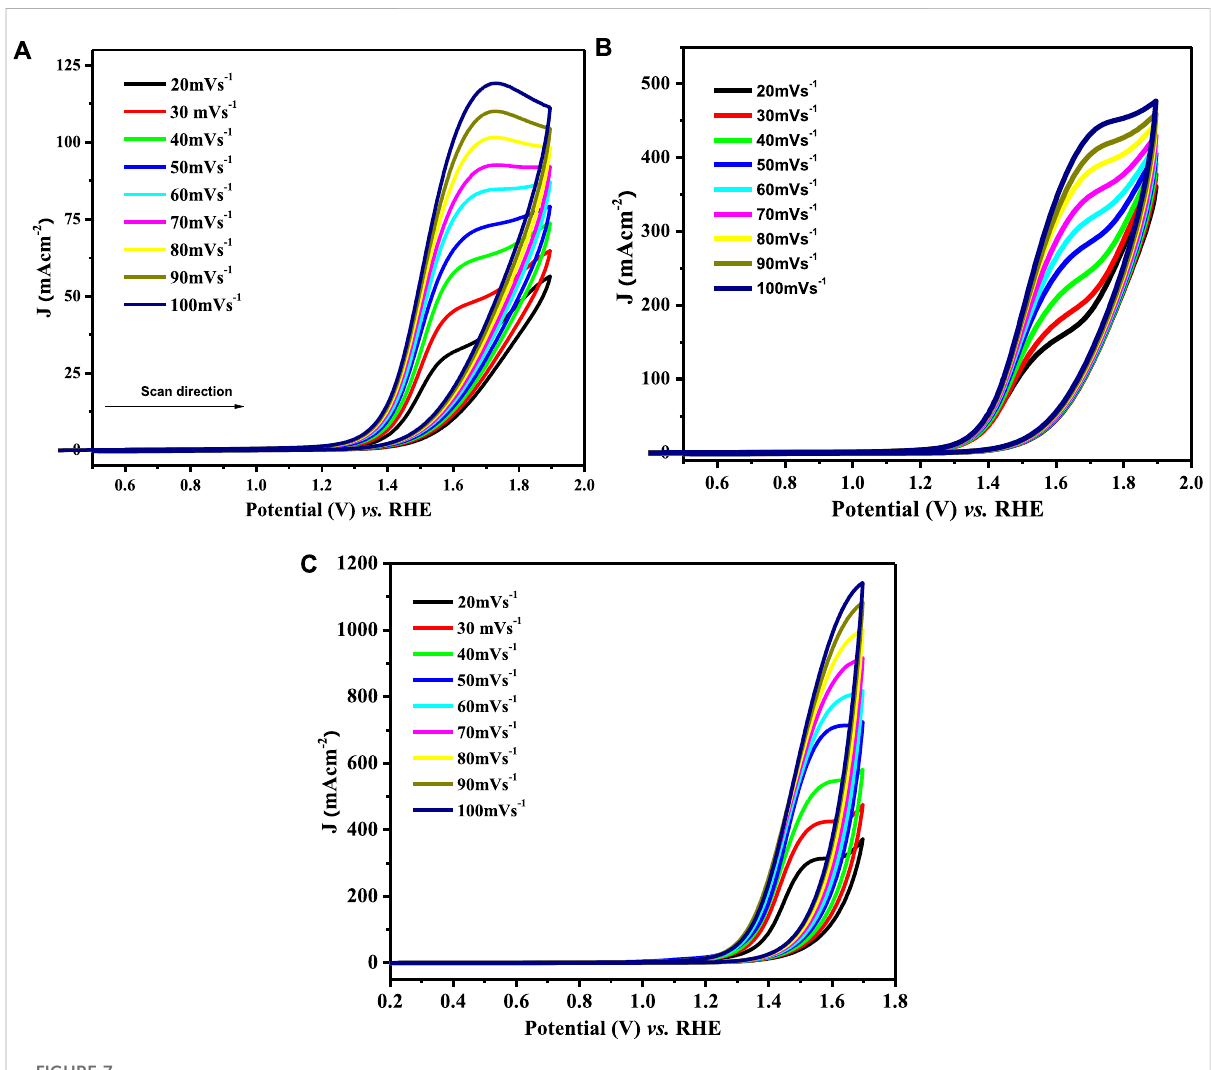
FIGURE 7 CV pro fi les for OER at (A) LCNiO-1/GCE, (B) LCNiO-5/GCE, and (C) LCNiO-9/GCE in 1 M methanol +1 M KOH at different scan rates (20 – 100 mV s − 1 ).